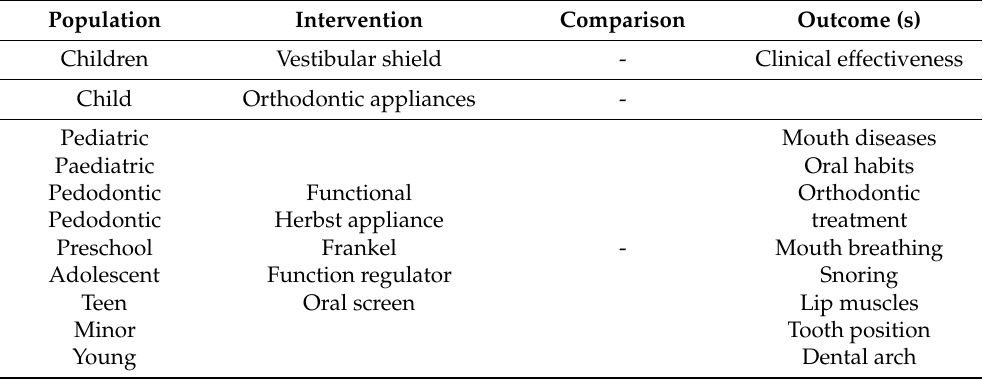
Table 1. MeSH terms and alternate terms were used in PICO format for the search. Population Intervention Comparison Outcome (s) Children Vestibular shield - Clinical